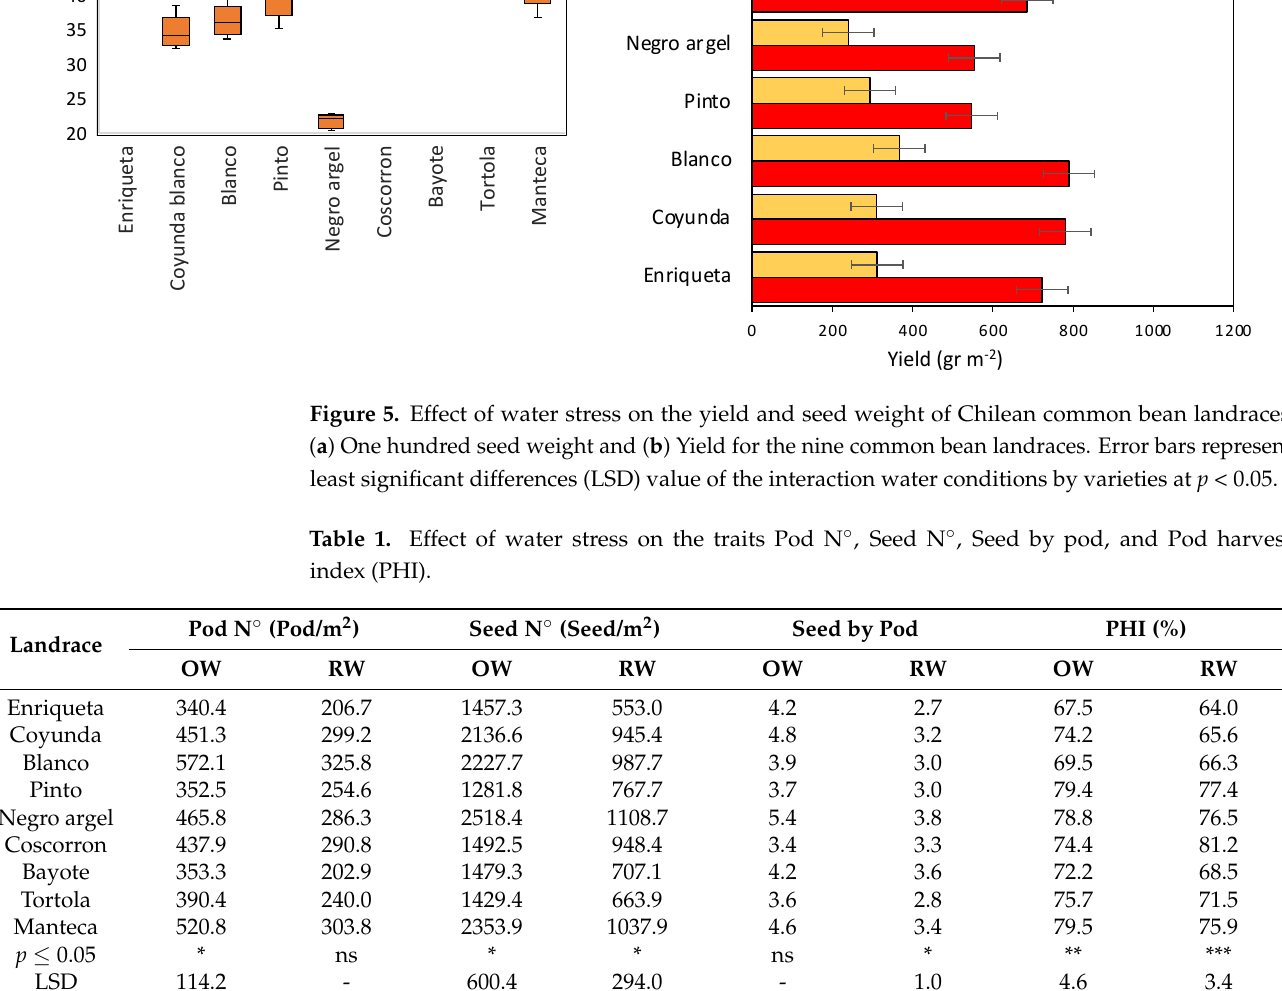
Table 1. Effect of water stress on the traits Pod N°, Seed N°, Seed by pod, and Pod harvest index (PHI). Landrace